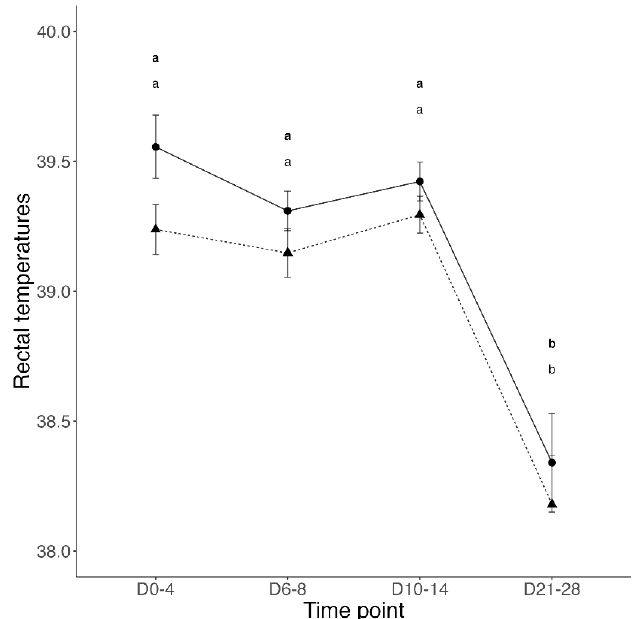
Figure 2. Mean ± SEM rectal temperature (°Celsius) during days 0 to 4, 6 to 8, 10 to 14, and 21 to 28 after challenge of calves vaccinated intranasally (IN) with a modified-live virus (MLV) BRSV vaccine in the first 6 h of life (dashed line and triangles) versus control calves (solid line and circles) subsequently challenged with BRSV. For each group and time point, the circle or triangle represents the mean, and the whiskers represent the SEM. A line for each group connects the group’s mean rectal temperature progression throughout the study. Data were analyzed using generalized mixed-effects models. Distinct letters (small caps a, b, c) represent significant ( p < 0.05) difference between time-points within participants of each group (Vacc in bold).